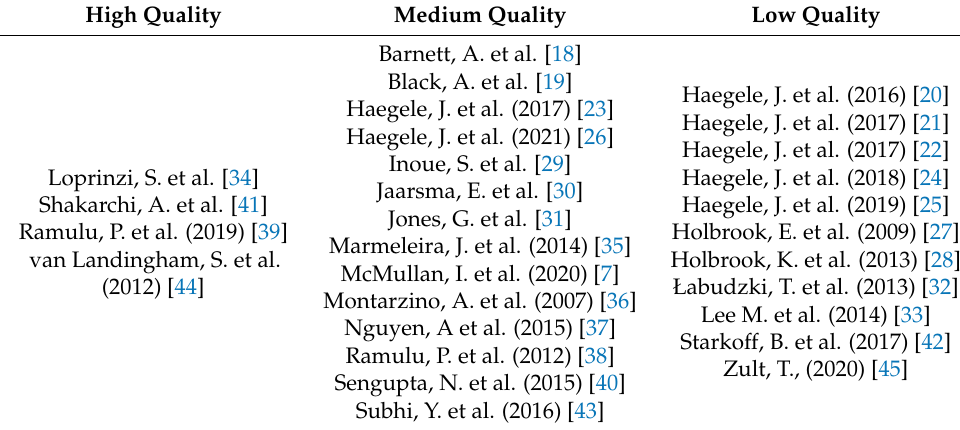
Table 2. Quality assessment.